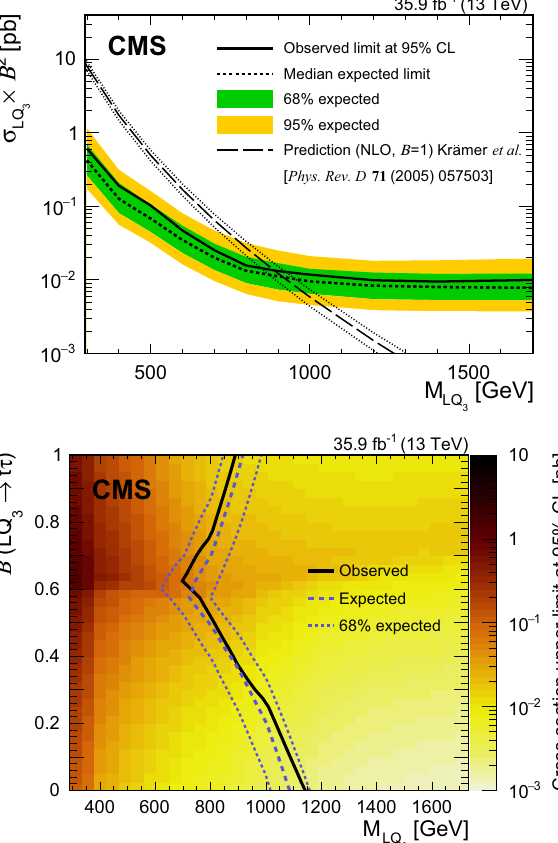
Fig. 6 Upper limits at 95% confidence level on the product of the cross section and the branching fraction squared (upper), and on the leptoquark mass as a function of the branching fraction (lower), for the pair production of scalar LQs decaying to a top quark and a τ lepton. In the top plot, the theoretical curve corresponds to the NLO cross section with uncertainties from PDF and scale variations [24], shown by the dotted lines. The bottom plot additionally includes results from a search for pair-produced bottom squarks [38]